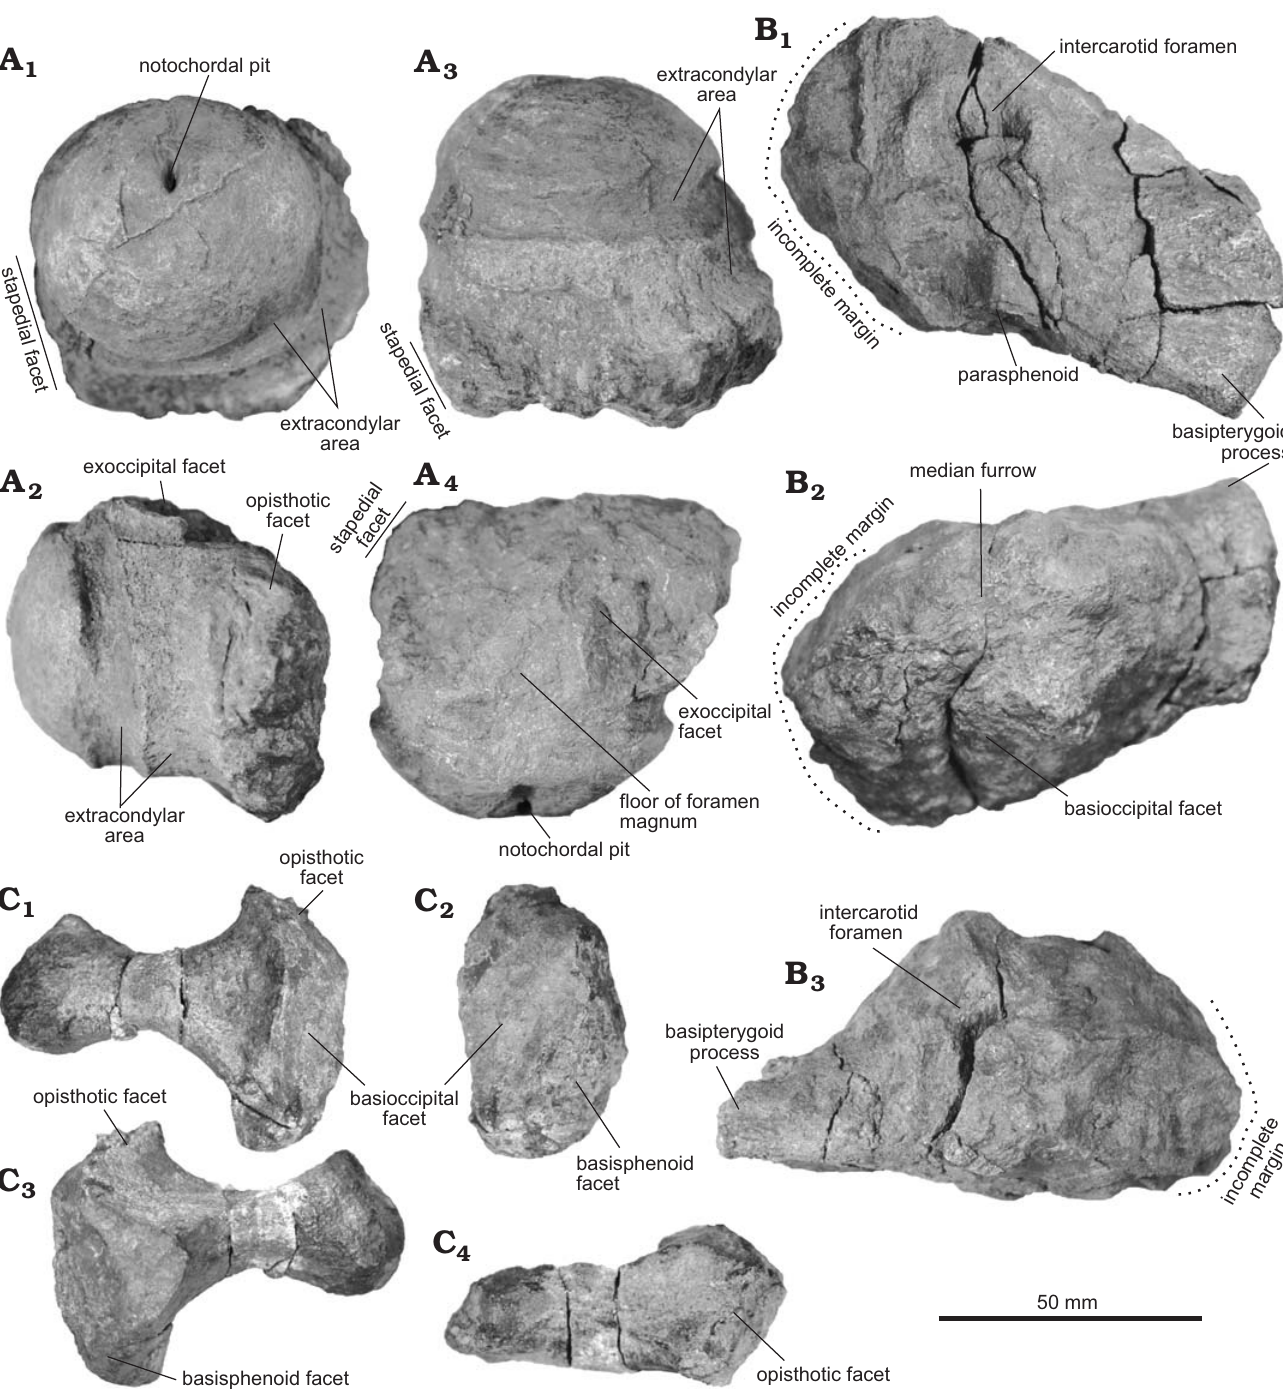
Fig. 10. Basicranium of ophthalmosaurid ichthyosaur Undorosaurus ? kristiansenae Druckenmiller, Hurum, Knutsen, and Nakrem, 2012 (PMO 214.578, ho- lotype) from Spitsbergen, Svalbard, Slottsmøya Member Lagerstätte, Tithonian. A . Basioccipital posterior (A 1 ), right lateral (A 2 ), ventral (A 3 ) and dorsal (A 4 ) views. B . Basi sphenoid in ventral (B 1 ), dorsal (B 2 ), and anterior (B 3 ) views. C . Left stapes in posterior (C 1 ), medial (C 2 ), anterior (C 3 ), and dorsal (C 4 ) laterally wider than dorsoventrally tall and the extracondylar Description .— Basioccipital (Fig. 10A): The dorsal and parts area is largely visible. Surrounding the condyle on all sides of the left lateral surfaces of the basioccipital from PMO is a ring of unfinished bone. Anterior to this is a wider ex- 214.578 ( Undorosaurus ? kristiansenae ) are damaged. The tracondylar area forming a second ring on the lateral and floor of the foramen magnum is narrowest anteriorly and in- ventral surfaces, also visible in posterior view (Fig. 10A ). In pos- creases in mediolateral width posteriorly (Fig. 10A 4 ), the occipital condyle is slightly medio- terior view (Fig. 10A This is different from PMO 222.667, Simbirskiasaurus bir- 1